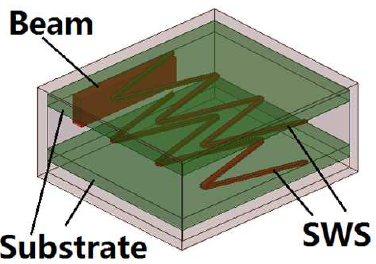
Figure 1. Sketch of the symmetric double V-shape MML SWS. Inspired by the above TWTs, we propose a novel SWS by parallel, connecting two MMLs together, and then symmetrical, placing them on both the top and bottom dielectric substrates of the cavity to form the four output ports. The two parallel MMLs are connected to each other by power dividers at the end and the whole input coupling structure is designed as a double microstrips–rectangular waveguide transition. Four coaxial cable output ports are connected to the SWS with microstrip lines. Two tapered attenuators are symmetrically inserted into the SWS to suppress the oscillations. The sketch of the novel SWS is shown in Figure 2, in which this 2 × 2 unit consists of one rectangular waveguide input port and four coaxial output ports. One sheet electron beam gun is employed in the beam–wave interaction processes of the TWT to further reduce the whole volume and weight.